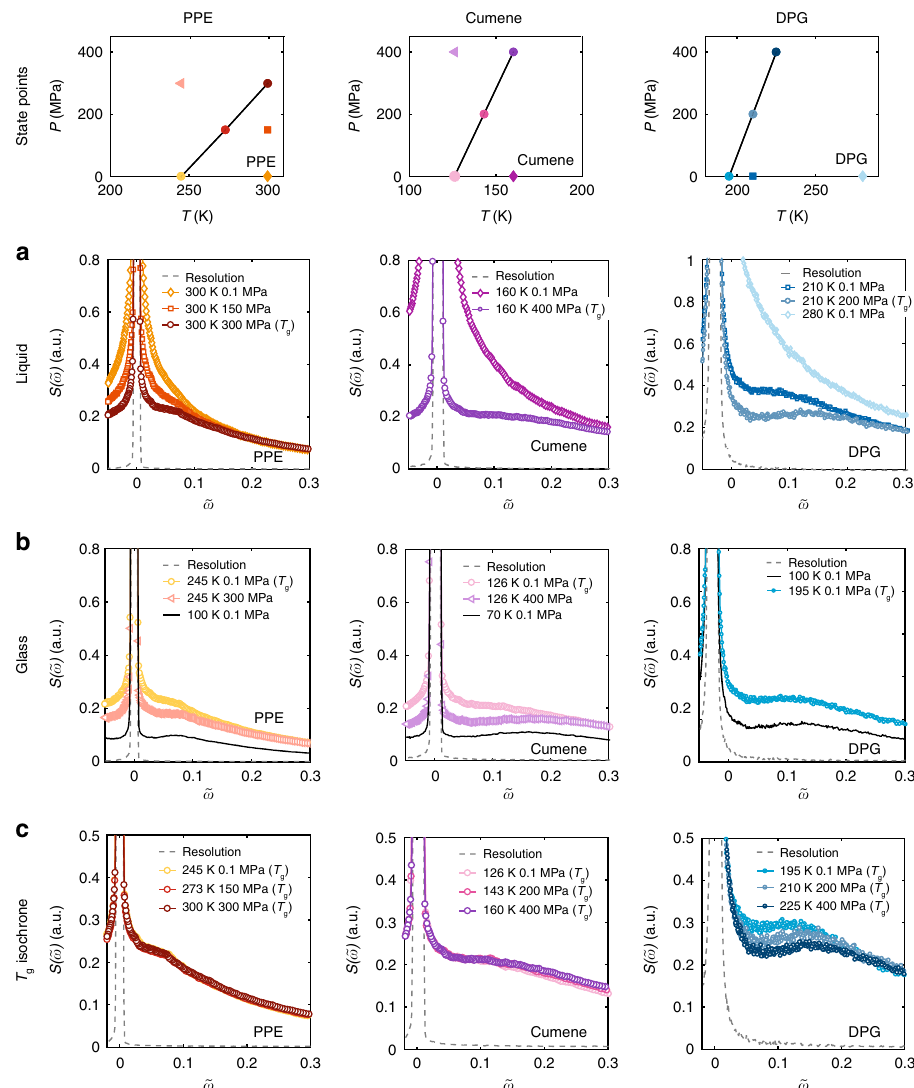
Fig. 2 Picosecond dynamics at various state points for PPE, cumene and DPG. Top panel: ( T , P )-phase diagram showing the state points of the spectra in row a – c . The black lines correspond to the glass transition isochrones with τ α = 100 s. All spectra are plotted in reduced units, ~ ω ¼ ωρ (cid:2) 1 = 3 T (cid:2) 1 = 2 and summed over Q . a Spectra in the liquid: at low pressure, we primarily observe relaxation. As pressure is increased, reaching the glass transition, only fast relaxation and vibrations are left. b Spectra in the glass: leaving the glass transition, going deeper into the glass, fast relaxations disappear and only vibrations are left. c Along the glass transition isochrones, there is superposition of dynamics for the two van der Waals liquids, PPE and cumene, while in the hydrogen bonding liquid, DPG, there is a clear shift in the data with pressure. PPE and cumene were measured on IN5 and DPG on IN6. No scaling has been done on the y -axis, i.e. all spectra are shown on the same S ð ~ ω Þ